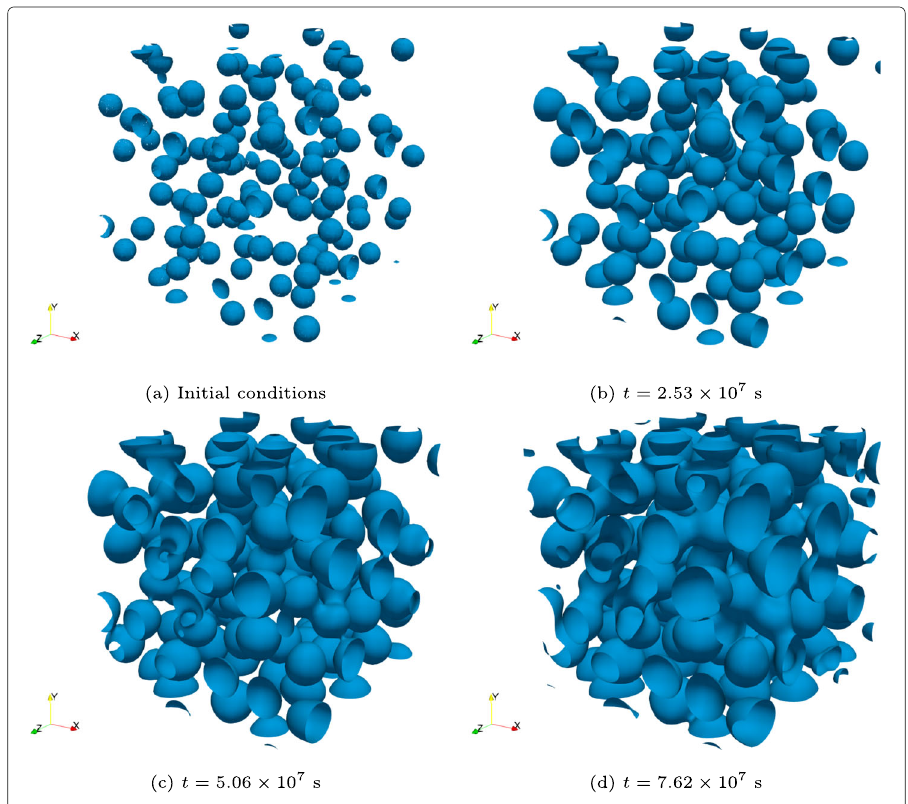
Fig. 1 Evolution of microstructure of Configuration 1 during simulation of gas bubble growth with s 0 = 5 × 10 − 9 s − 1 and D = 2 nm 2 /s. Simulation domain size is 72 μ m × 72 μ m × 72 μ m. Isosurface of c = 0.5 is shown. a initial conditions. b the bubbles have grown but none have begun to merge. c bubble merging and coalescence has begun. d a continuous path through the bubble phase exists from the simulation domain boundary at x = 0 μ m and the boundary at x = 72 μ m